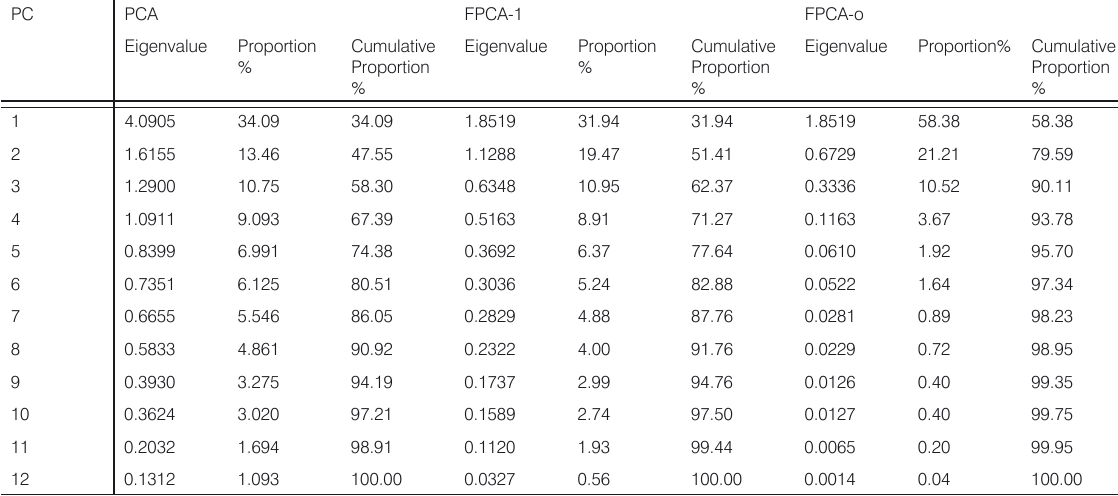
Table 5. Comparative eigenvalue and proportion corresponding to each principal component for PCA and FPCA.